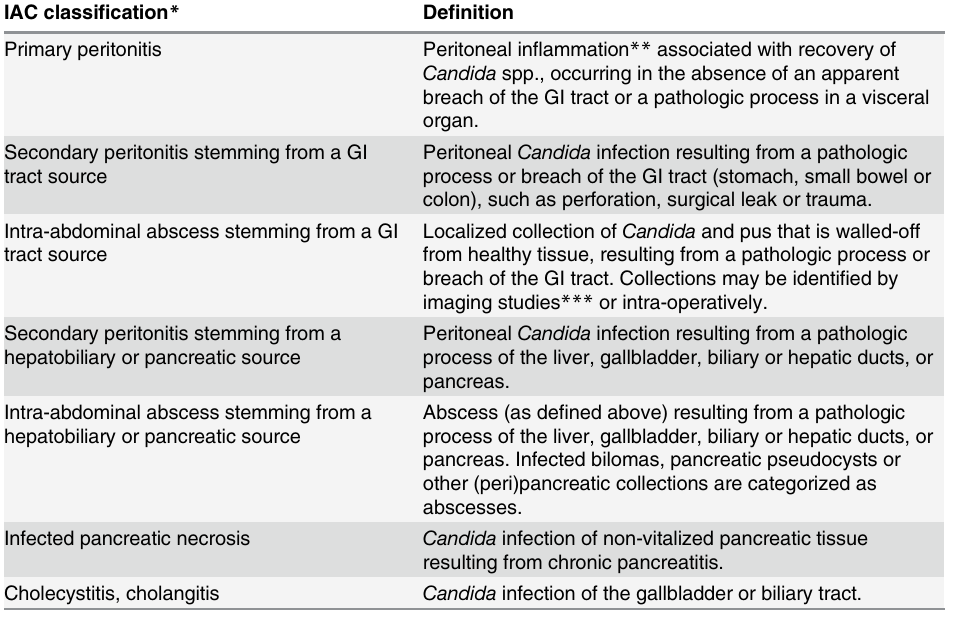
Table 1. Classification of types of intra-abdominal candidiasis